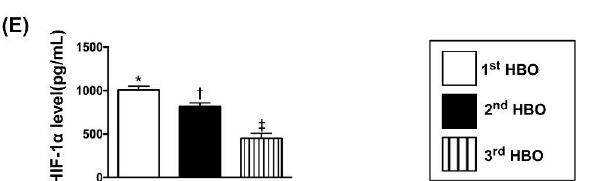
Figure 1. Time courses of circulating levels of inflammatory and soluble angiogenesis biomarkers. ( A ) Circulating level of interleukin (IL)-6, *, vs. other groups with different symbols (†, ‡), p < 0.0001. ( B ) Circulating level of hepatocyte growth factor (HGF), *, vs. other groups with different symbols (†, ‡), p < 0.0001. ( C ) Circulating level of vascular endothelial growth factor (VEGF), *, vs. other groups with different symbols (†, ‡), p < 0.0001. ( D ) Circulating levels of stromal cell-derived growth factor (SDF)-1 α , *, vs. other groups with different symbols (†, ‡), p < 0.0001. ( E ) Circulating level of hypoxia-induced factor (HIF)-1 α , *, vs. other groups with different symbols (†, ‡), p < 0.0001. All statistical analyses were performed by one-way ANOVA, followed by Bonferroni multiple comparison post hoc test ( n = 57 for each time interval). Symbols (*, †, ‡) indicate significance at the 0.05 level. “1st” indicates the blood sample was drawn prior to HBO therapy; “2nd” and “3rd” indicate the blood samples were drawn after the third and fifth sessions of HBO therapy, respectively.